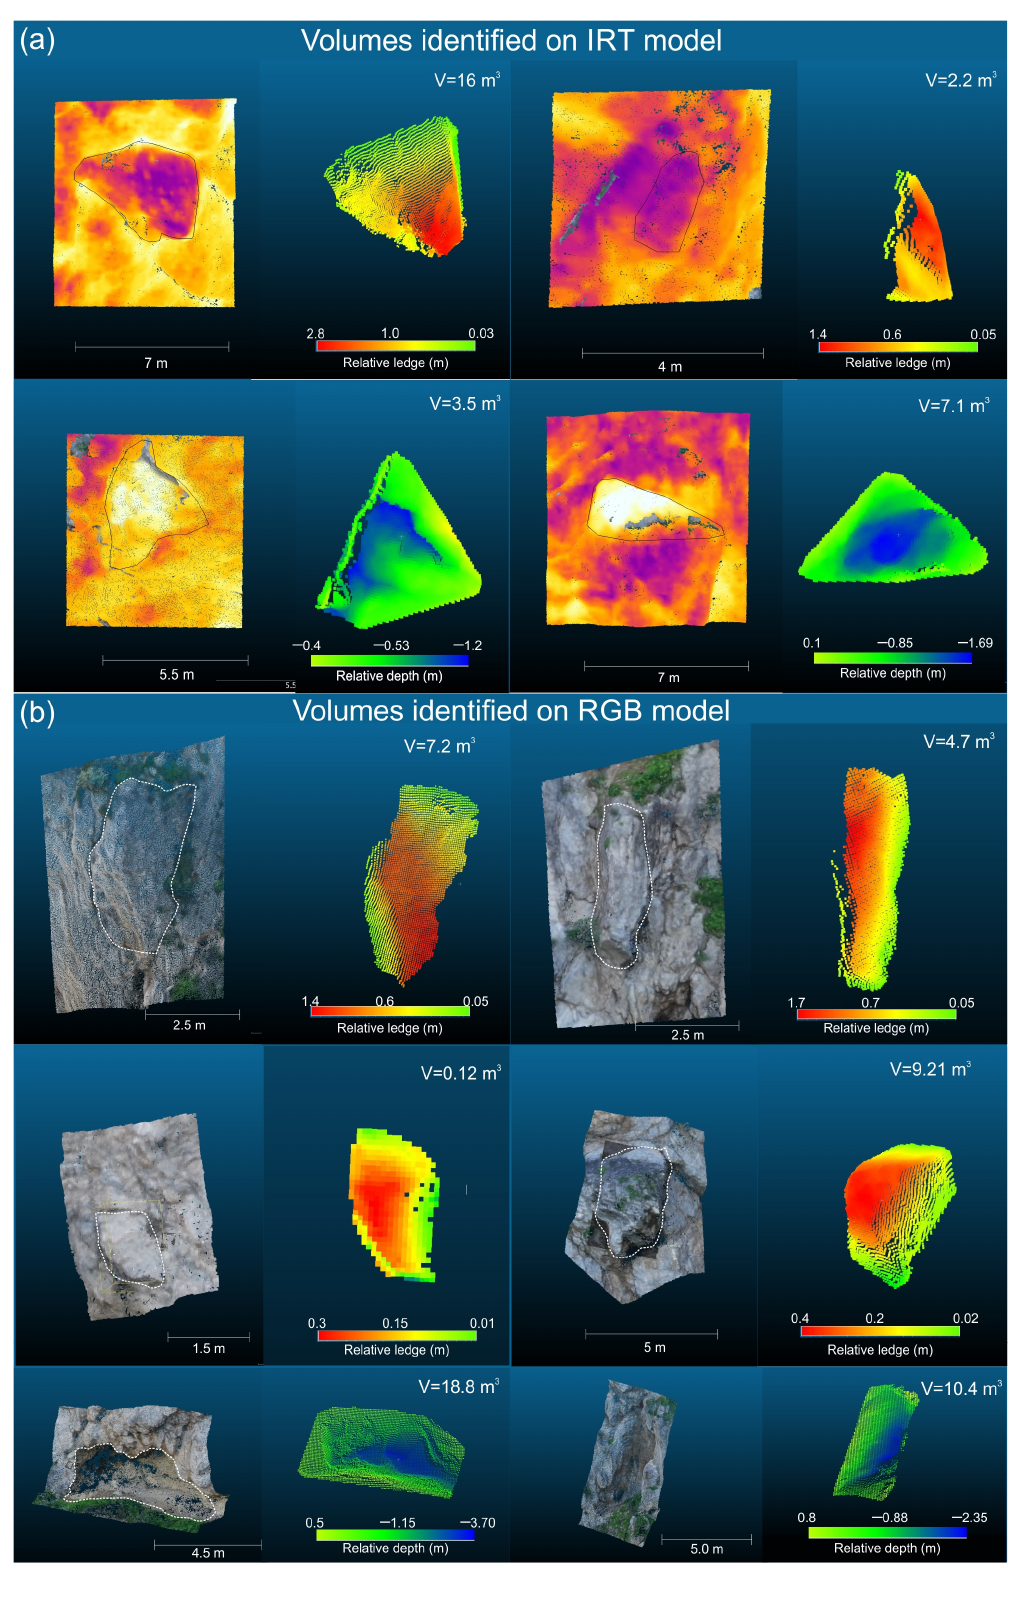
Figure 7. Location of the main protruding rock volumes, likely affected by instability, and empty areas likely related to past detachments. Some examples of block/cavity volume estimation on both IRT images ( a ) and dense point cloud ( b ), then measured on the digital outcrop model, are provided.